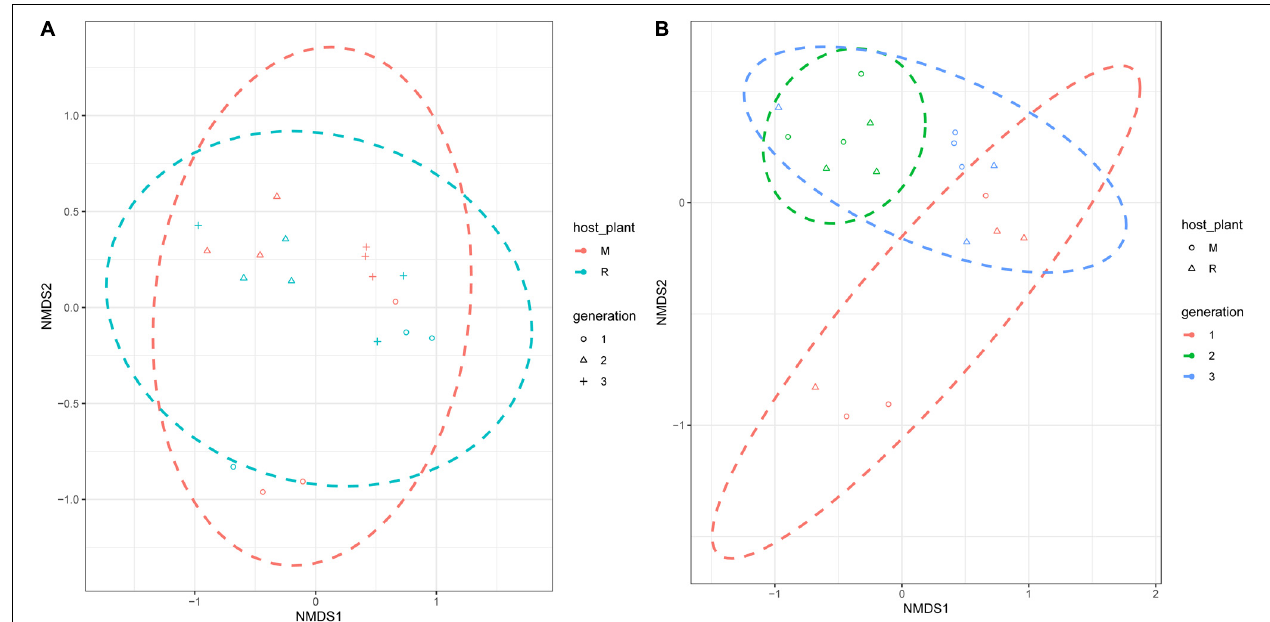
FIGURE 5 | NMDS analysis of the bacterial communities of C. medinalis fed maize and rice for three generations. NMDS plots were constructed using Bray–Curtis with the main groups of host plants (A) and generations (B) . Stress values (stress = 0.079) indicate a good fit in two dimensions. M: samples from C. medinalis fed maize; R: samples from C. medinalis fed rice.